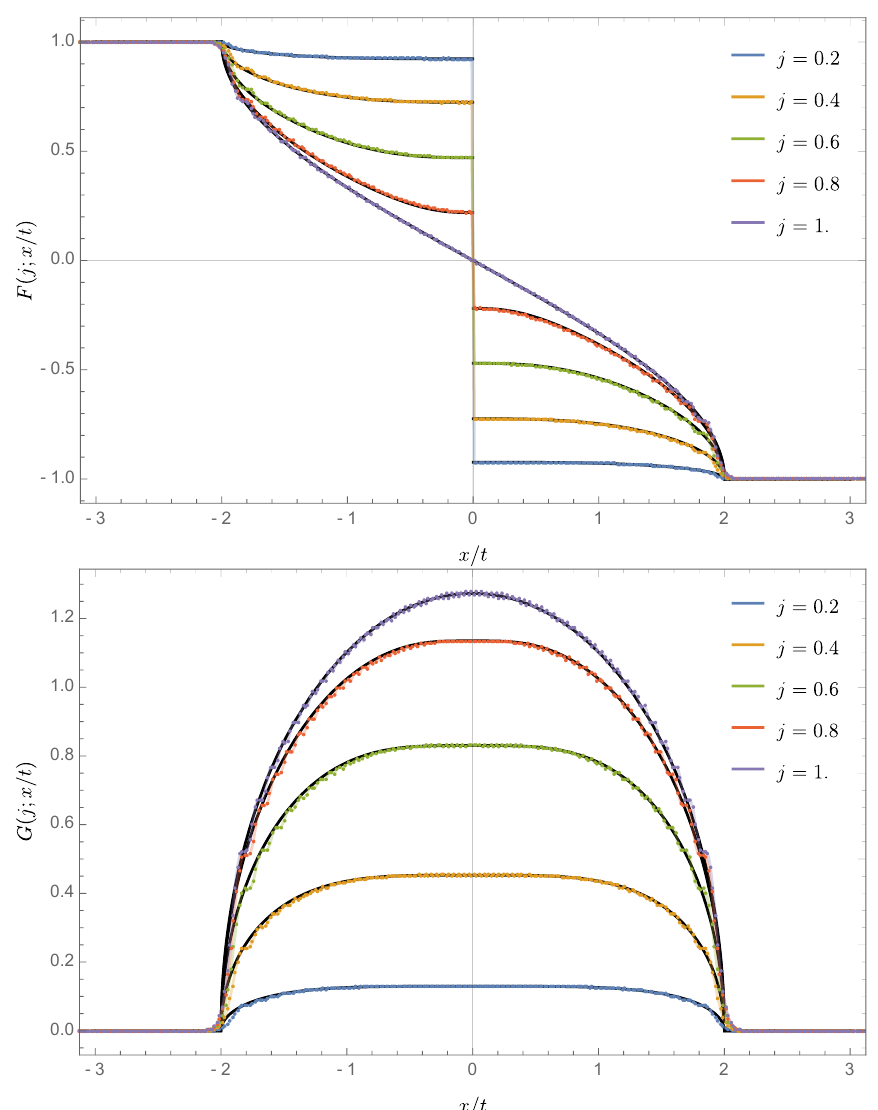
Figure 5: Asymptotics of the density n ∞ ( x / t ) ( top ) and current J ∞ ( x / t ) ( bottom ) as given by the scaling functions F ( j ; x / t ) and G ( j ; x / t ) respectively for different values of j ≤ 1. Coloured lines and points: numerical data at the maximum time reached ( t = 50), black lines: analytical expressions from (46) and